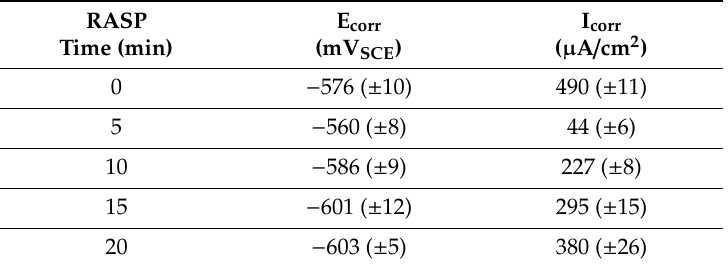
Figure 5. Potentiodynamic polarization curves of SA106B low-carbon steel for various RASP-processed periods ranging from 0 min to 20 min: ( a ) 0.05 M H 2 SO 4 + 0.05 M Na 2 SO 4 solution; ( b ) 0.2 M NaCl + 0.05 M Na 2 SO 4 solution at room temperature. Table 2. Electrochemical parameters of SA106B low-carbon steel for various RASP-processed periods ranging from 0 min to 20 min in the 0.05 M H 2 SO 4 + 0.05 M Na 2 SO 4 solution.